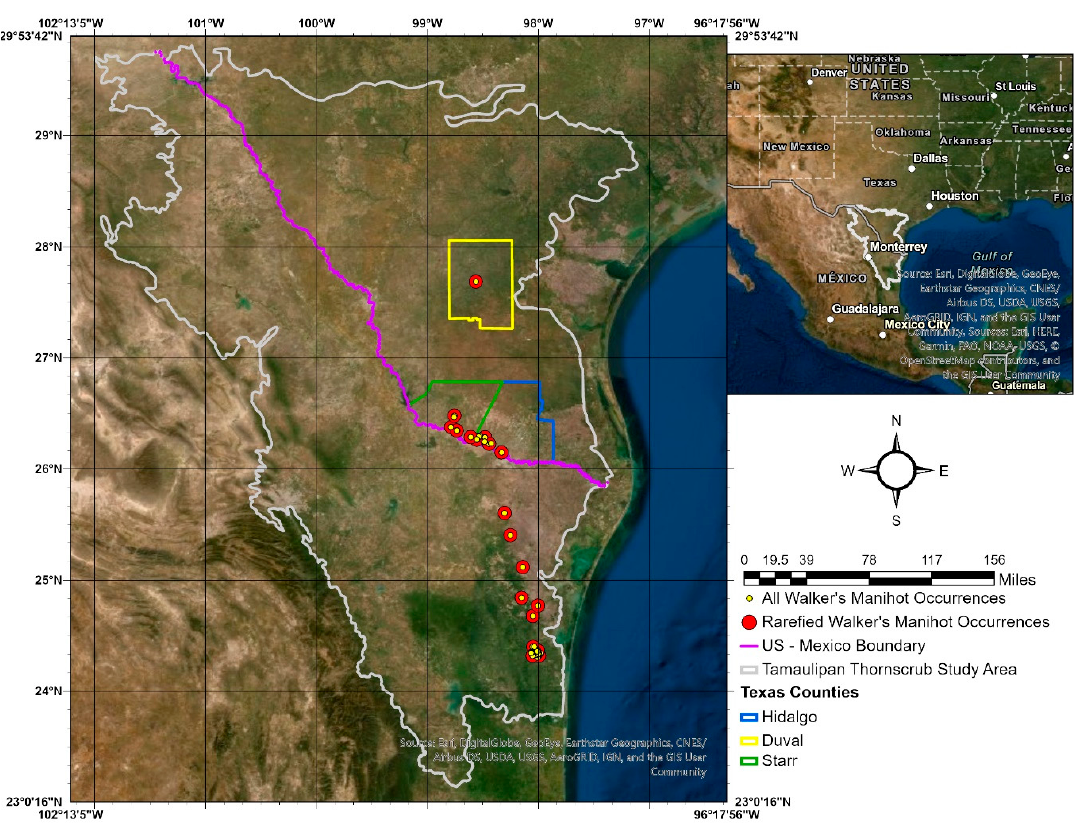
Figure 1. Known occurrences for Manihot walkerae in Texas and Mexico within the Tamaulipan Thornscrub ecoregion study area. The yellow dots represent all 399 known occurrences for M. walkerae , and the red dots represent the 19 4 km spatially rarefied occurrences.